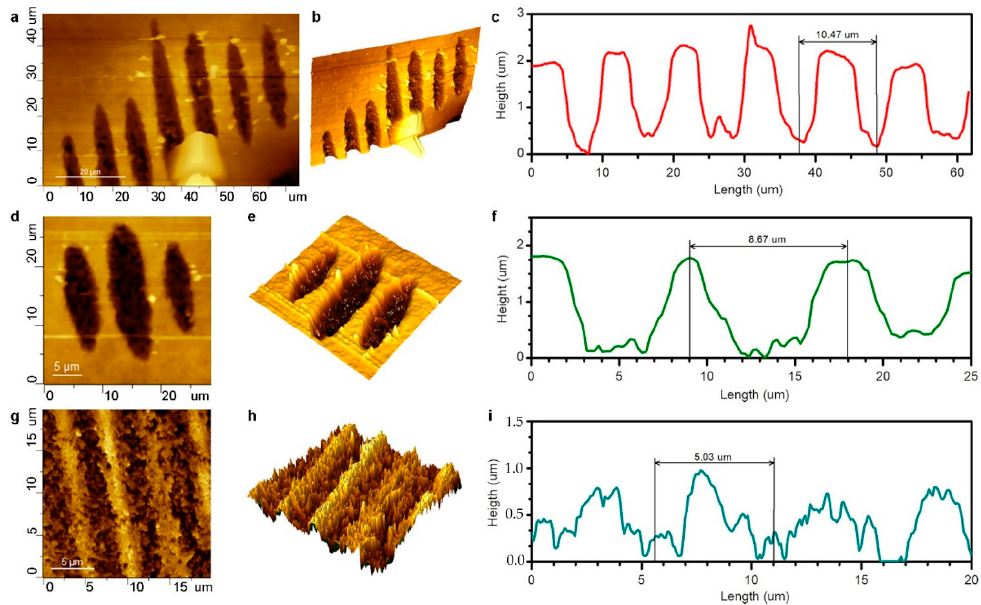
Figure 4. AFM analysis of three types of laser patterns corresponding to periods of ( a – c ) 10.5, ( d – f ) 8.7, and ( g – i ) 5 µm.